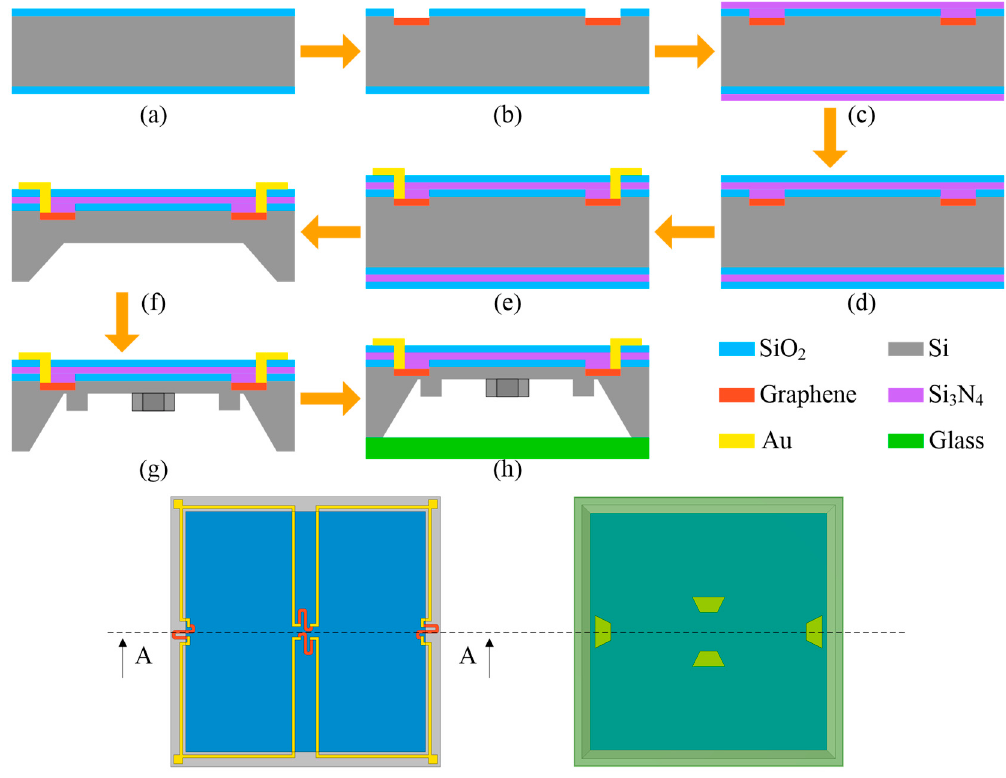
Figure 14. The primary manufacturing process of the suggested sensor chip.